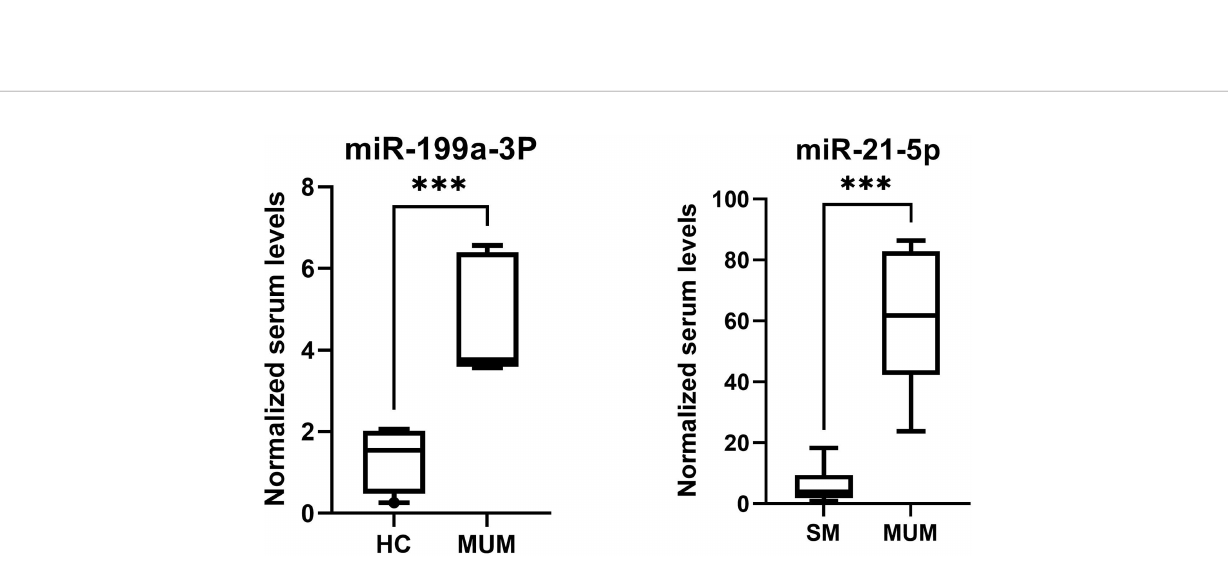
FIGURE 8 | The higher levels of miR-199a-3p of metastatic UM patients in comparison to healthy controls (HC) and higher levels of miR-21-5p of metastatic UM patients (MUM) in comparison to patients with localized spindle shaped melanoma (SM). *** p <